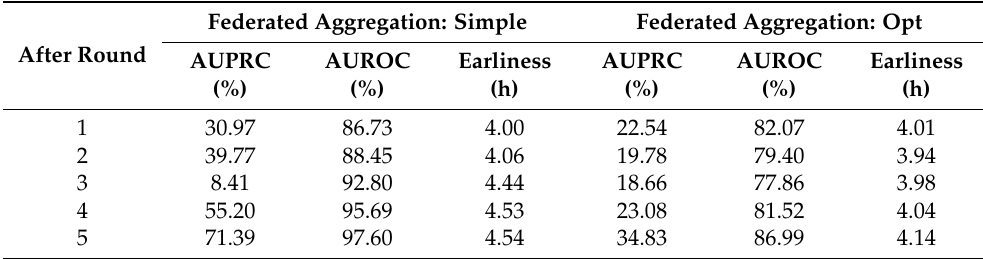
Table 8. Evaluation results using non-text input features in a federated learning setting using 10 Raspberry Pi